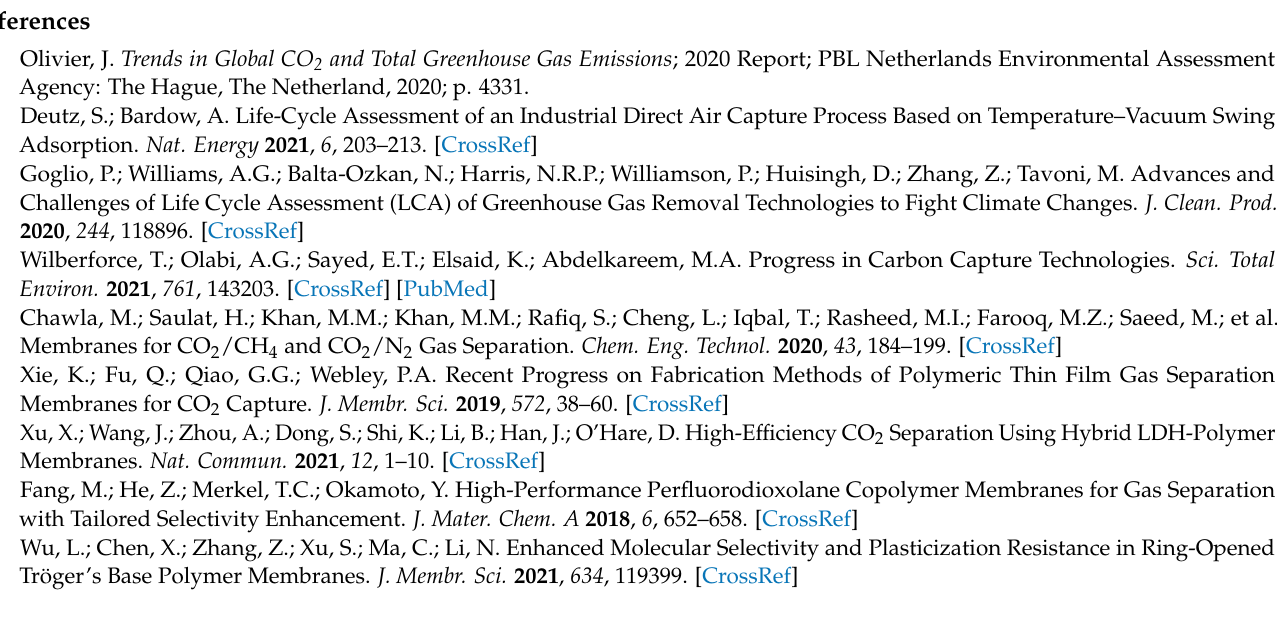
Figure A3. The schematic of polycondensation reaction of resorcinol with formaldehyde in the presence of KOH as